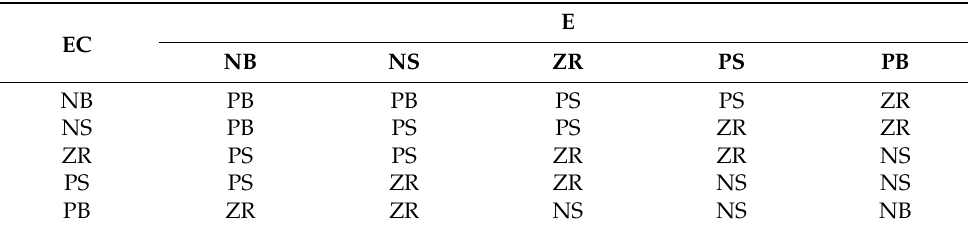
Table 5. Fuzzy control rules.